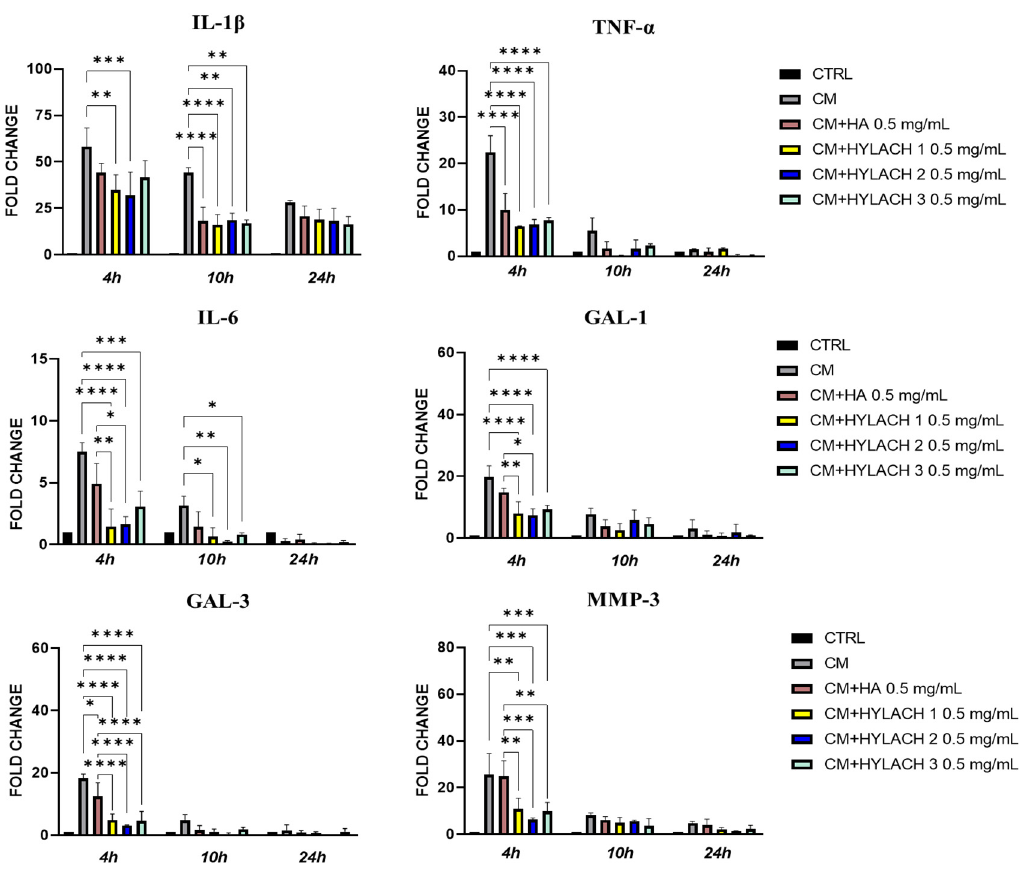
Figure 5. Bronchial fibroblast expression of proinflammatory and MMP molecules after exposure to U937 CM in the presence or absence of HYLACH with different degrees of lactosylation. Cells were exposed for 24 h to the CM of activated U937 and then cultured in the presence or absence of 0.5 mg/mL HA and HYLACH. RNA transcript levels specific for IL-1 β , TNF- α , IL-6 , Gal-3 , Gal-1 , and MMP-3 were evaluated by qPCR, as described in the Materials and Methods section at 4, 10, and 24 h after treatment. Statistical differences are based on a one-way ANOVA test and data are expressed as mean ± SE obtained from three independent experiments. * p < 0.05 and ** p < 0.01; *** p < 0.001, and **** p < 0.0001. Percentage of lactose-derived residues: HYLACH 1 = 10%, HYLACH 2 = 30%, and HYLACH 3 = 40%.